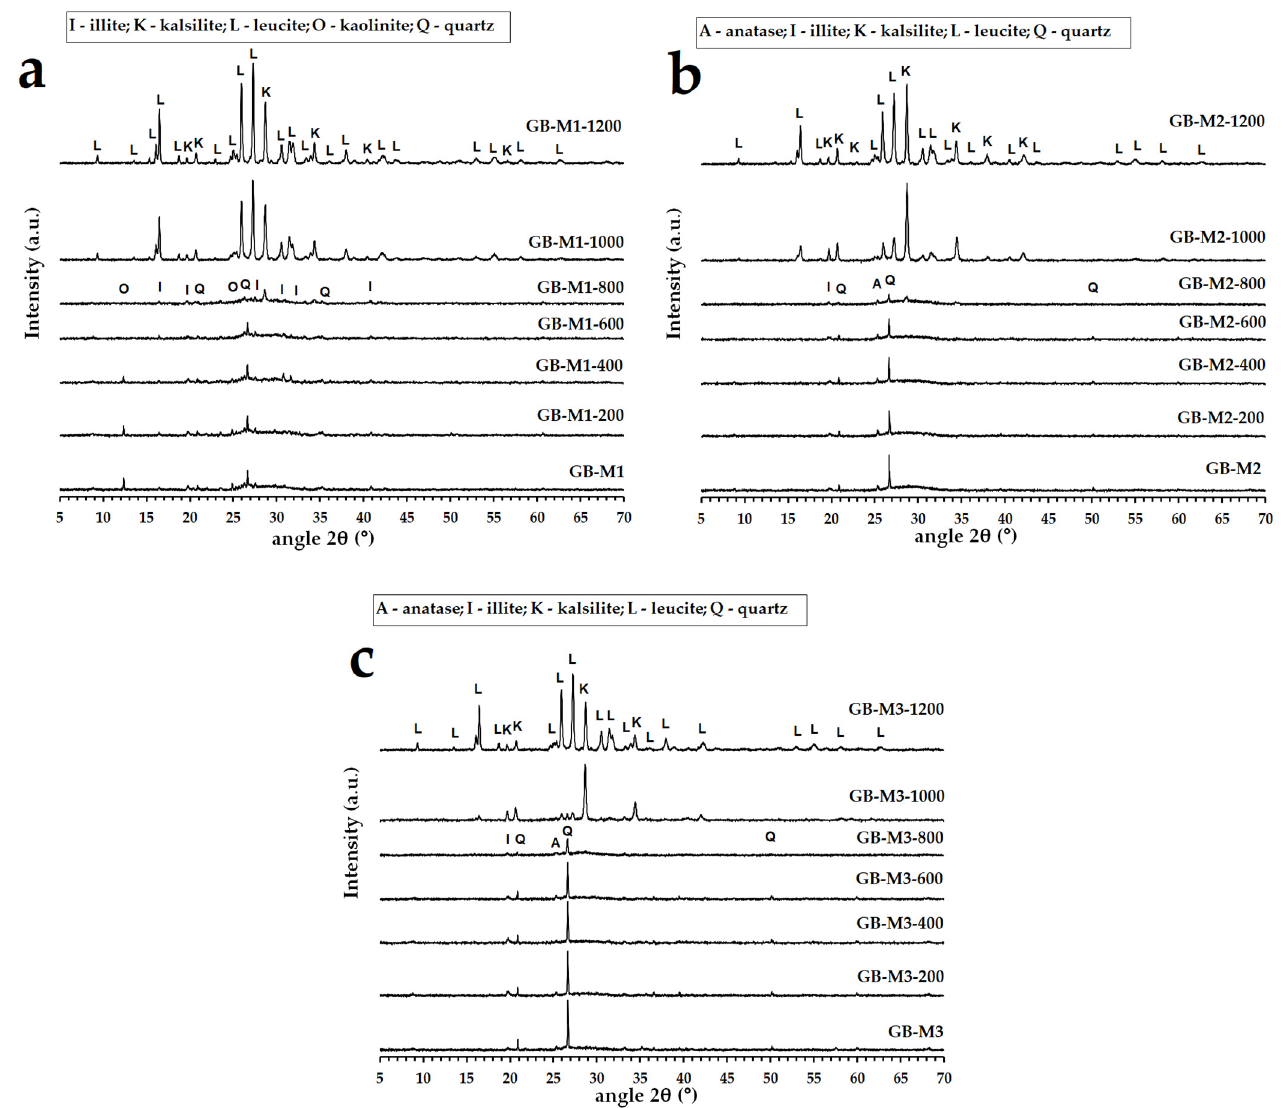
Figure 4. XRD patterns of the geopolymer binders with different type of aluminosilicate (( a )—GB-M1, ( b )—GB-M2, ( c )—GB-M3) at laboratory temperature and after exposure up to 1200 °C.